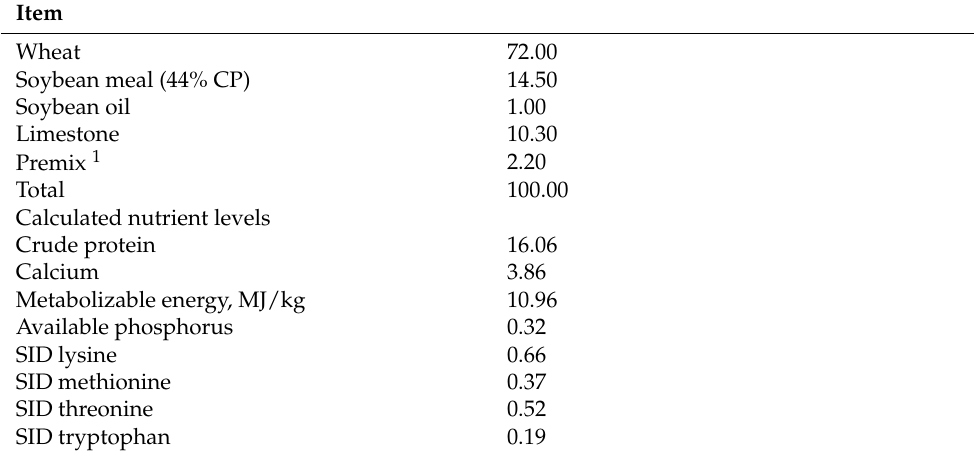
Table 1. Ingredient and nutrient levels of the experimental diets (%, as-fed